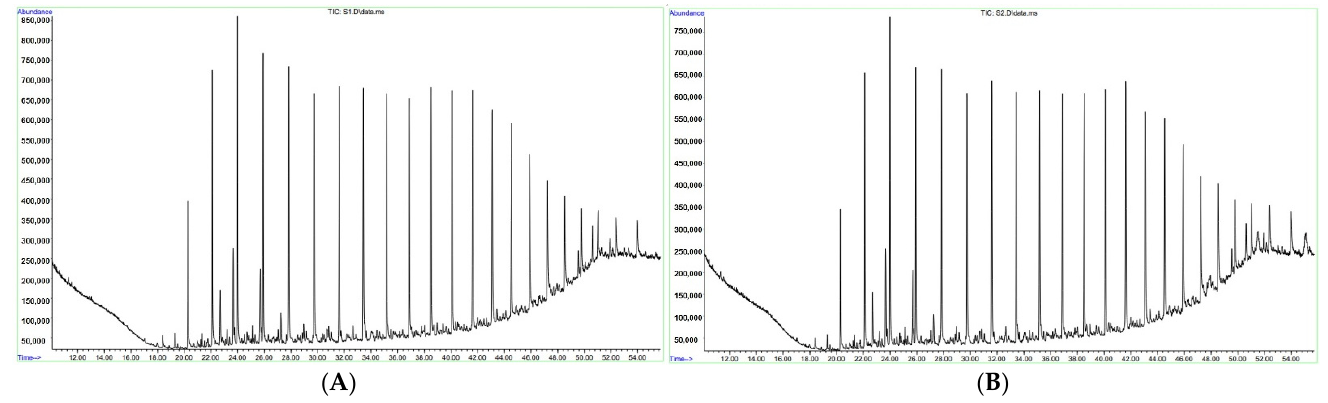
Figure 1. Chromatogram of ARPD solvent ( A ) and chromatogram of ARPD + solution + EVA sample ( B ).